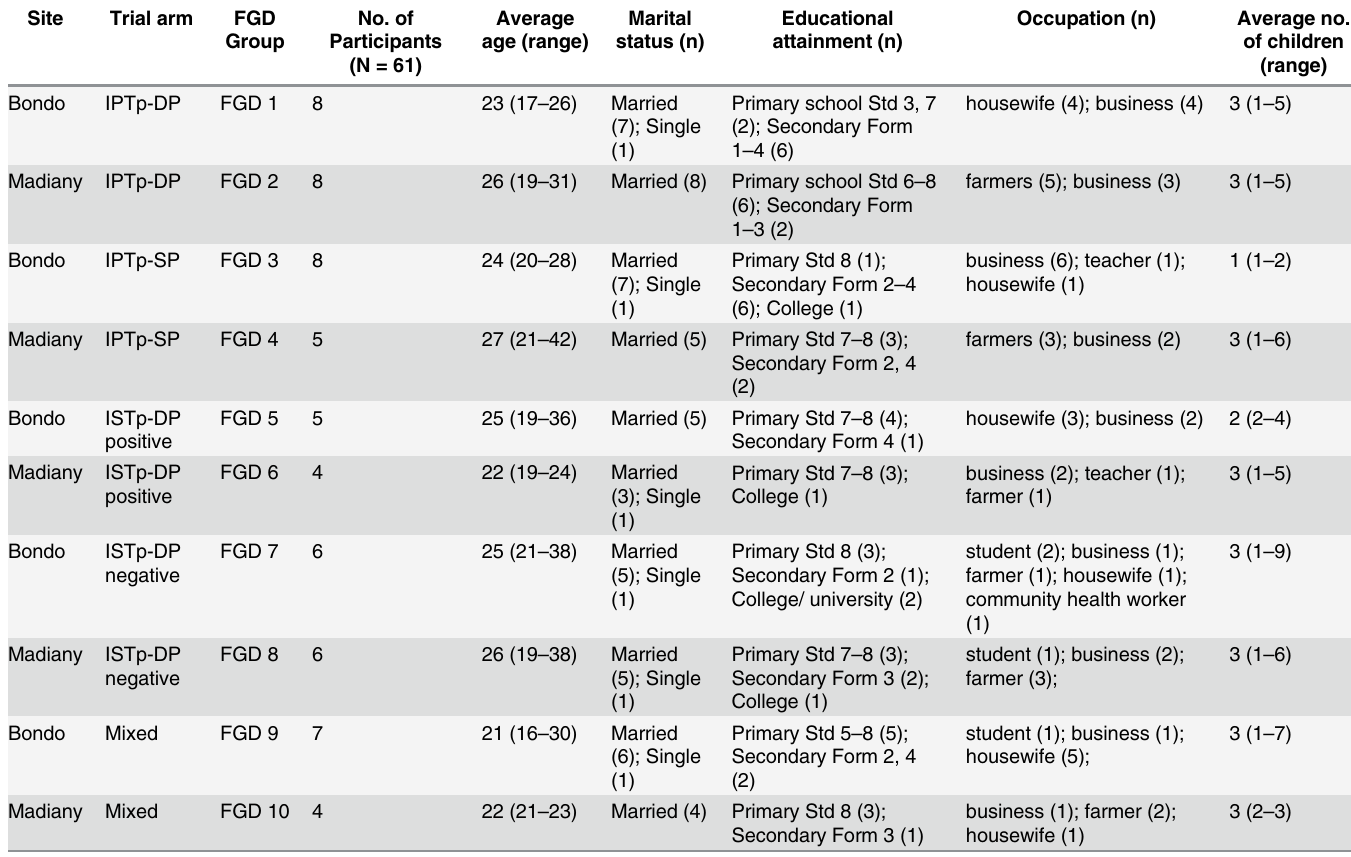
Table 1. Characteristics of trial participants in the focus group discussions.